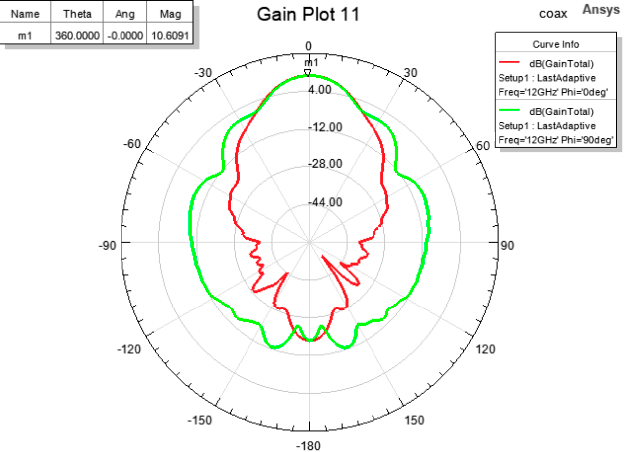
Figure 7. Simulation of the E-plane and H-plane radiation patterns of the horn antenna at 12 GHz.